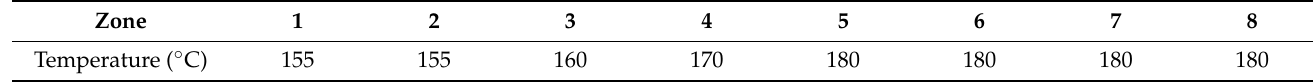
Table 1. Extrusion processing temperature.